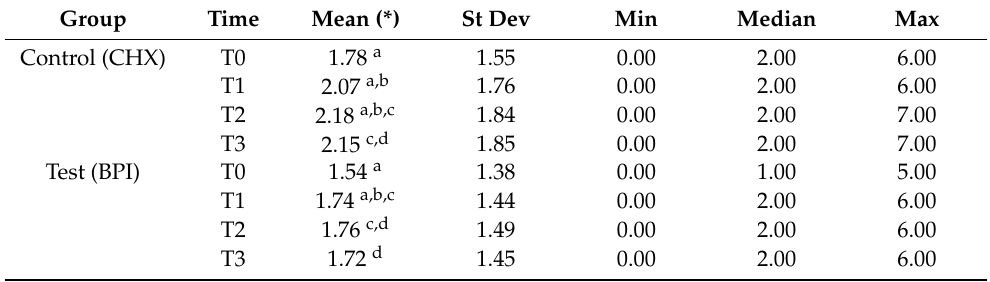
Table 2. Descriptive statistics of recession (R).